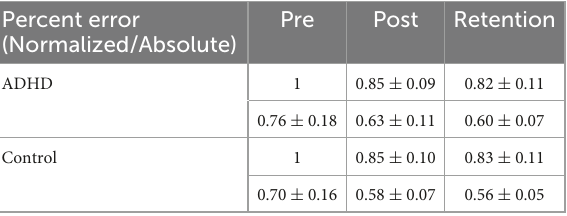
TABLE 1 Illustrating normalized/absolute performance values for the novel force-matching task (FMT). Percent error Pre Post Retention (Normalized/Absolute) ADHD 1 0.85 ± 0.09 0.82 ± 0.11 0.76 ± 0.18 0.63 ± 0.11 0.60 ± 0.07 Control 1 0.85 ± 0.10 0.83 ± 0.11 0.70 ± 0.16 0.58 ± 0.07 0.56 ±